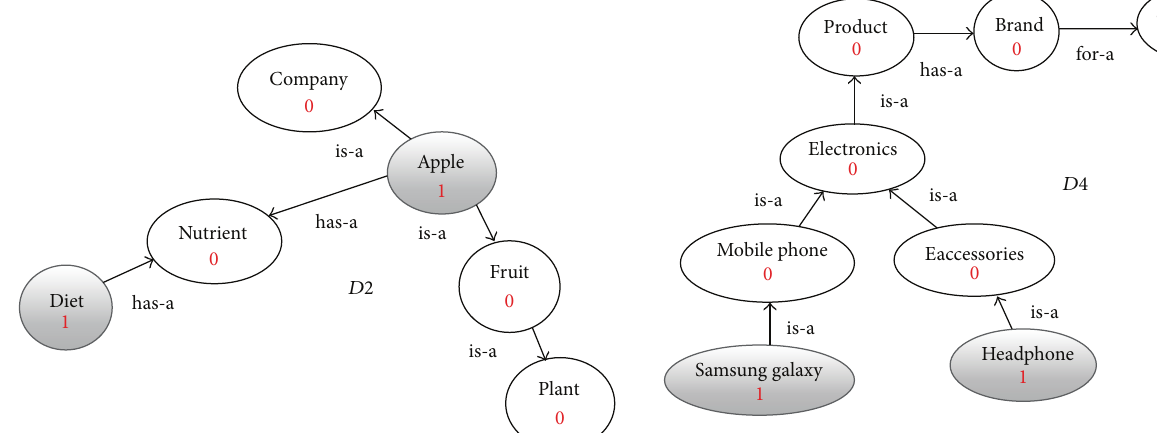
Figure 3: Enriched graph for 𝐷1 .